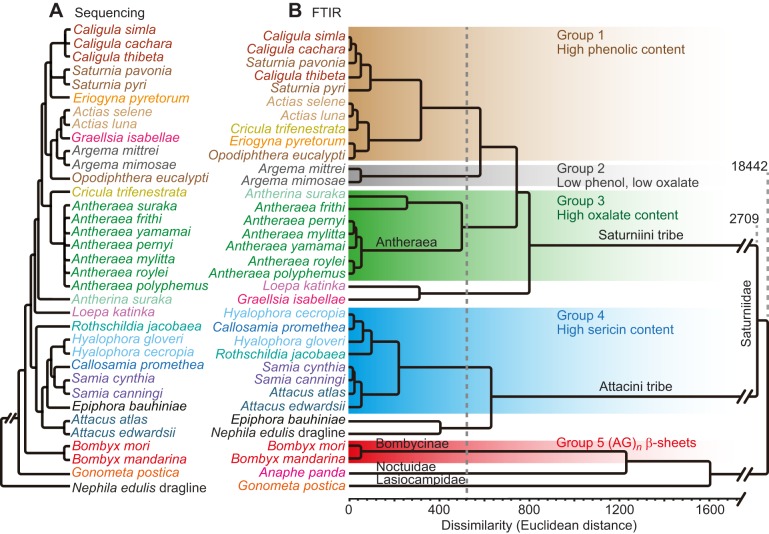
Classification of silk species. (A) Cladogram generated from the phylogenetic analysis of Regier et al. (2005, 2008a,b, 2002; see also Chen et al., 2012c). (B) Ultrametric tree generated from the hierarchical clustering analysis of cocoon infrared spectra LDA factor scores. Species with a Euclidean distance smaller than 525 were grouped together. FTIR, Fourier transform infrared spectroscopy.